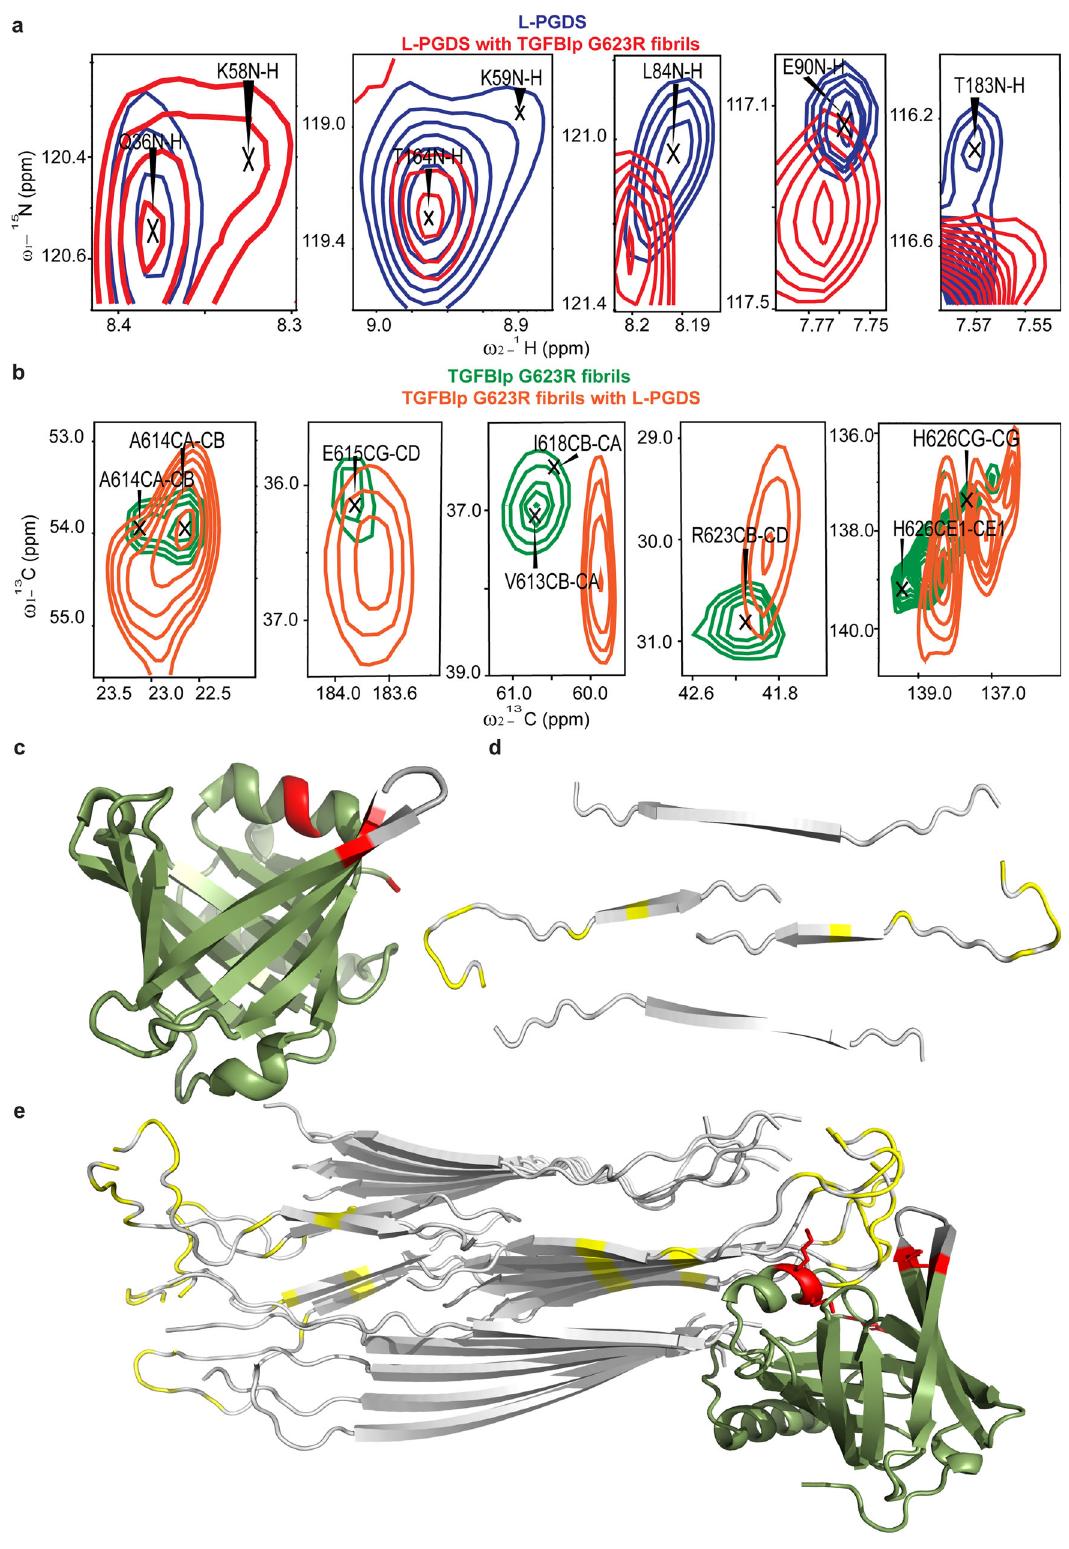
Fig. 3 Mapping of interactions between G623R fi bril and L-PGDS. a Selected residues of 1 H- 15 N HSQC spectra of the 15 N-labeled L-PGDS in the absence (blue) and presence of G623R fi brils (red). b 13 C- 13 C DARR spectra of the 13 C and 15 N-labeled G623R fi brils in the absence (green) and presence of L-PGDS (orange). c , d Residues of L-PGDS and G623R fi bril, respectively, exhibiting signi fi cant chemical shift changes as highlighted in red and yellow. e NMR data-guided docking model of G623R fi bril and L-PGDS (PDB code: 4IMN) 3